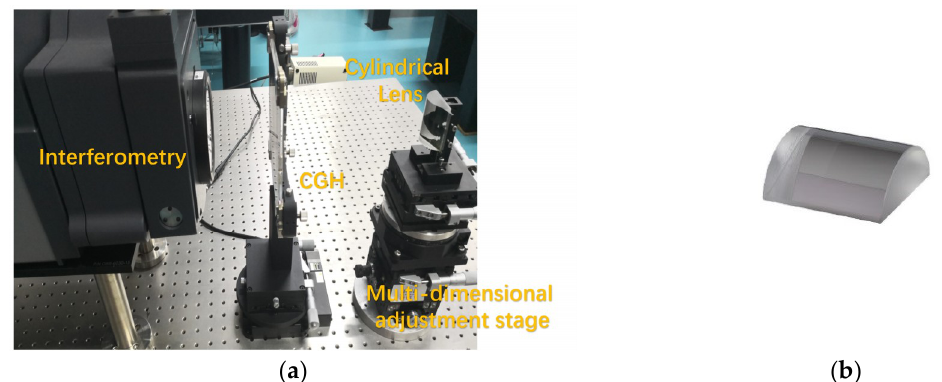
Figure 5. ( a ) Photograph of the experimental system and ( b ) the experimental sample. Appl. Sci. 2018 , 8 , x